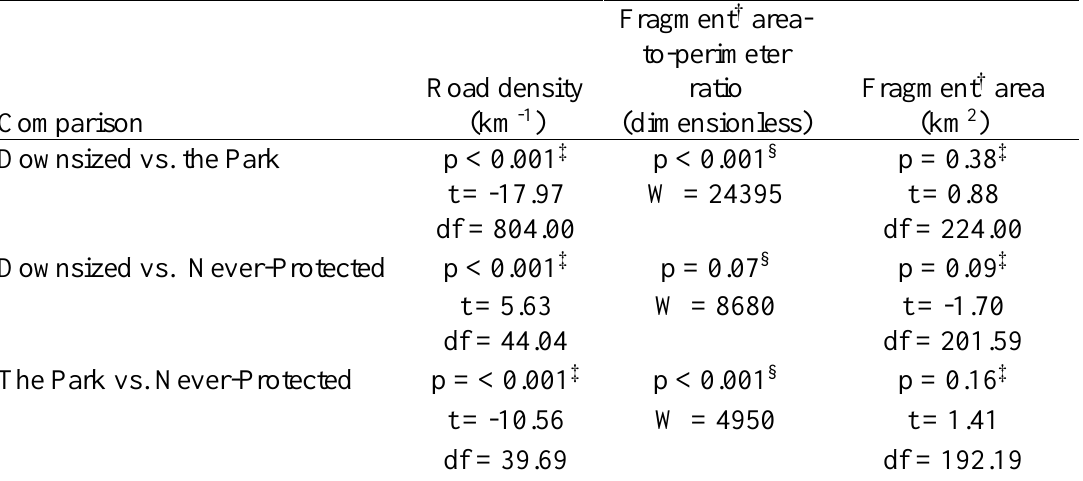
Table A1.11: Habitat fragmentation at the Park scale for all land cover types. Never-protected lands delineated using a 1 km buffer. Results of post-hoc tests from Table